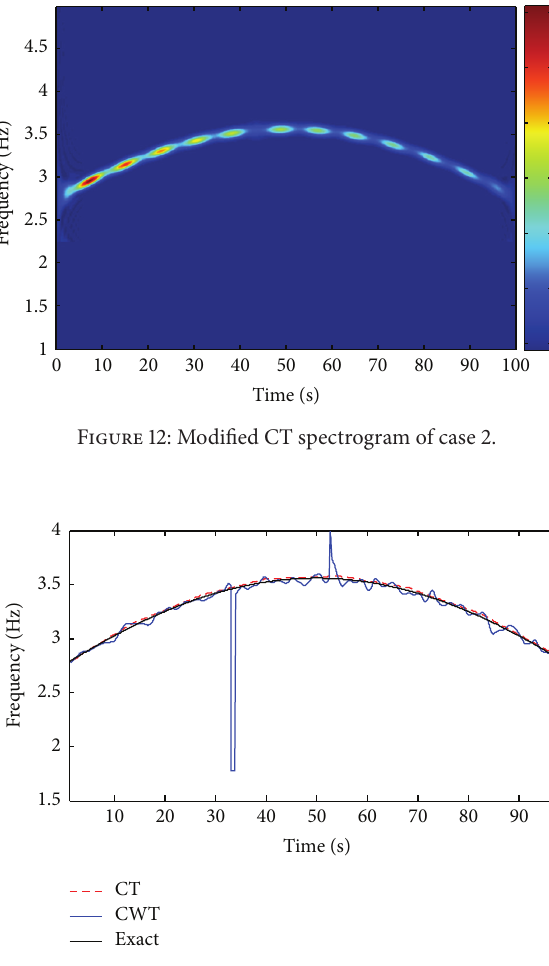
Figure 13: Identification results of case